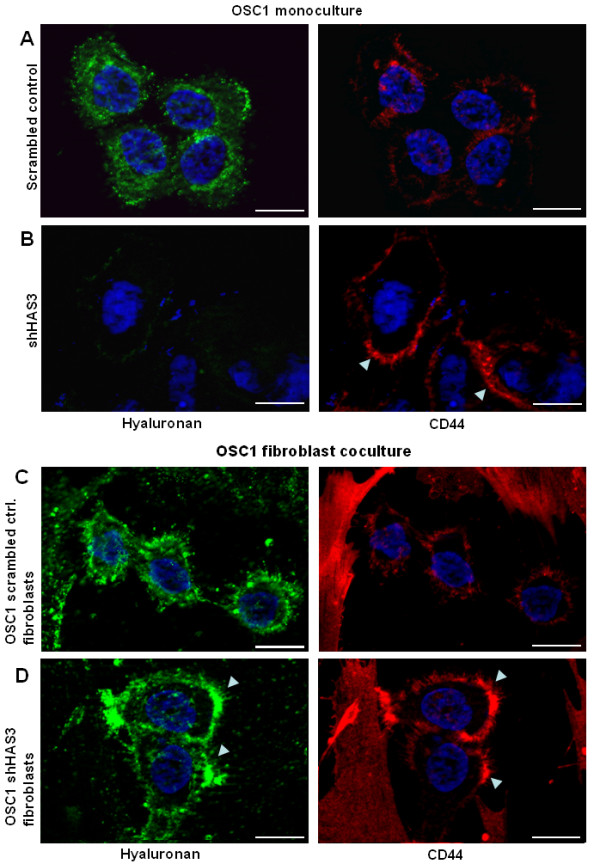
Co-culture of OSC1 cells and fibroblasts suggested binding of stromal HA to the tumour cell surface via CD44. OSC1 cells were cultured alone and with fibroblasts to gain mechanistic insight into the origin of OSC1-bound HA in shHAS3 transduced OSC1 cells. (A) In monoculture OSC1 cells showed a strong staining for HA (green) and a weak signal for CD44 (red). (B) Transduction with shHAS3 strongly decreased HA deposition (green) and increased CD44 expression (red, arrows). (C) In co-cultures OSC1 cells exhibited similar pericellular HA as compared to controls in A. (D) In contrast shHAS3 transduced OSC1 cell still exhibited a strong pericellular HA signal (green, arrows) in the presence of fibroblasts that co-localized with increased CD44 (red, arrows). Scale bars, 10 μm. Shown are representative images of n = 3.